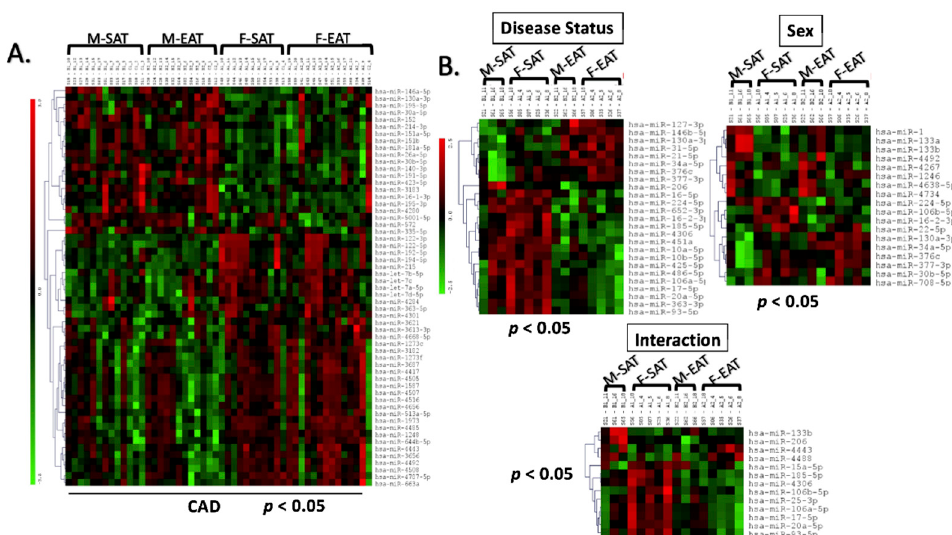
Figure 3. Sex specific differences in miRNA regulation in EAT and SAT from patients with CAD: microRNA microarray on EAT and SAT samples from patients with CAD showed sex-specific differences in expression. Unpaired t -test ( p < 0.05) significantly altered microRNAs are displayed ( A ). Two-way ANOVA showed significant differences in microRNAs and interactions between both sex and disease status and interactions were observed ( B ).